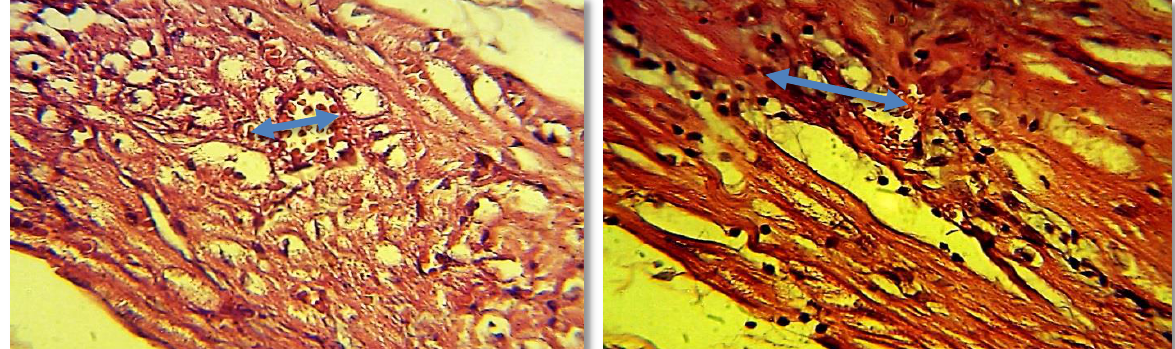
Figure,5: Section in the cardiac muscle of rabbit treated with methionine over load at the end of experiment (group T1). Note: congestion of blood vessels with inflammatory cells in their lumen as well as vacuolar degeneration of muscle cells (H &E stain 40X).